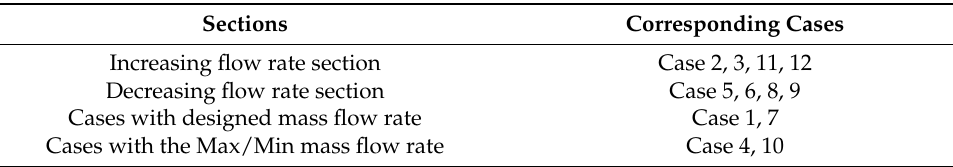
Table 2. Section division and its corresponding case.